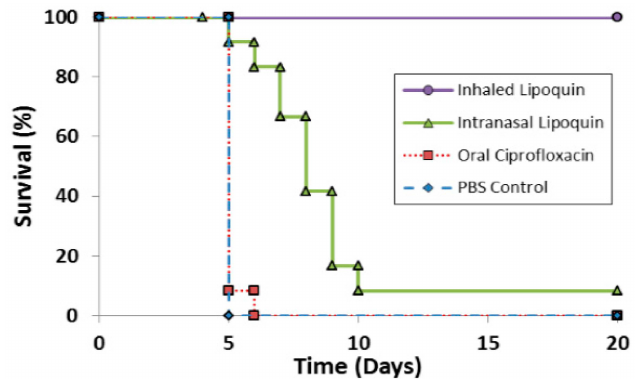
Figure 10. Therapeutic efficacies of oral ciprofloxacin, intranasal Lipoquin, and inhaled Lipoquin aerosol against inhalational F. tularensis Schu S4 infection in mice. Groups of 12 BALB/c mice were challenged with F. tularensis Schu S4 via the aerosol route and treated at 24 h post-challenge with 50 mg/kg of oral ciprofloxacin (red squares, dotted line), 50 mg/kg of intranasal Lipoquin (green triangles, solid line), a 1-mg/kg lung dose of aerosolized Lipoquin (purple circles, solid line), or intranasal phosphate buffered saline (PBS) (blue diamonds, dashed line). Graph shows the survival of mice treated with a single dose of antibiotic. Reprinted with permission from [50]. Copyright 2014 American Society for